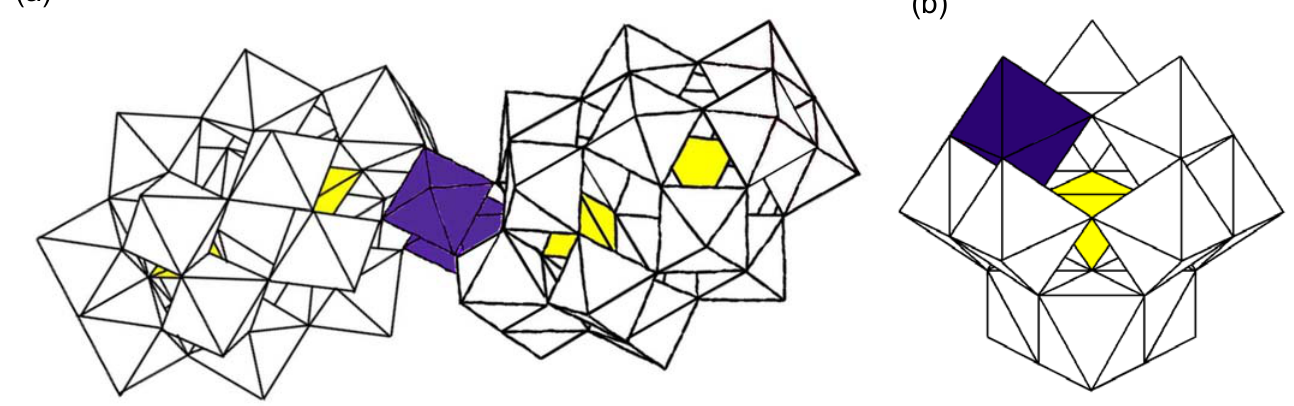
Figure 1. Polyhedral representation of (a) [O{Re V (OH)( α Re V O ] 4- ( 2 ). The one and two rhenium groups are represented by the purple [PW 11 40 octahedra. The WO and internal PO 6 yellow tetrahedra,